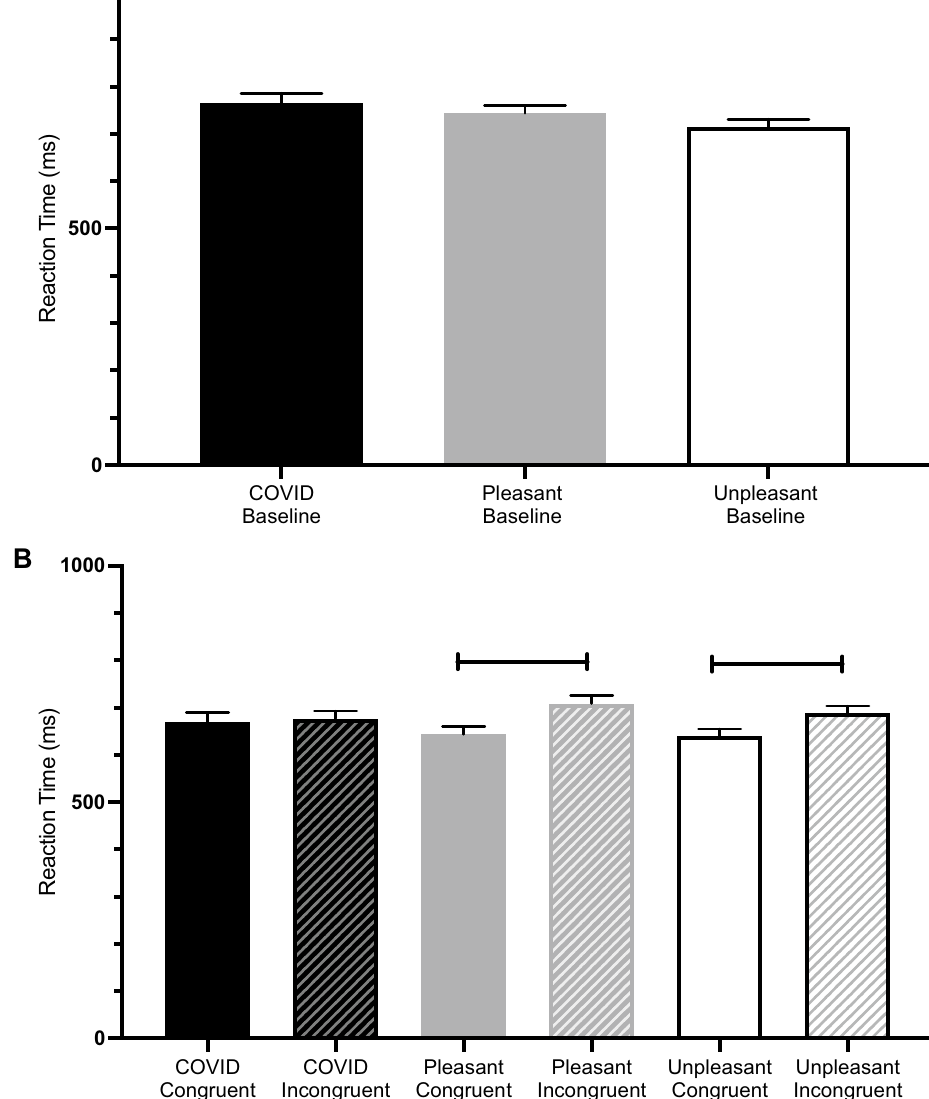
Figure 3. ( A ) The baseline reaction times for each of the COVID-19 (black), pleasant (grey), and unpleasant (white) word categories. ( B ) The congruent (solid) and incongruent (striped) prime-target reaction times for each of the COVID-19 pleasant and unpleasant word categories. Reaction times were shorter for congruent pleasant and congruent unpleasant word pairs, showing affective priming for these categories. There was no decrease in reaction time for COVID congruent word